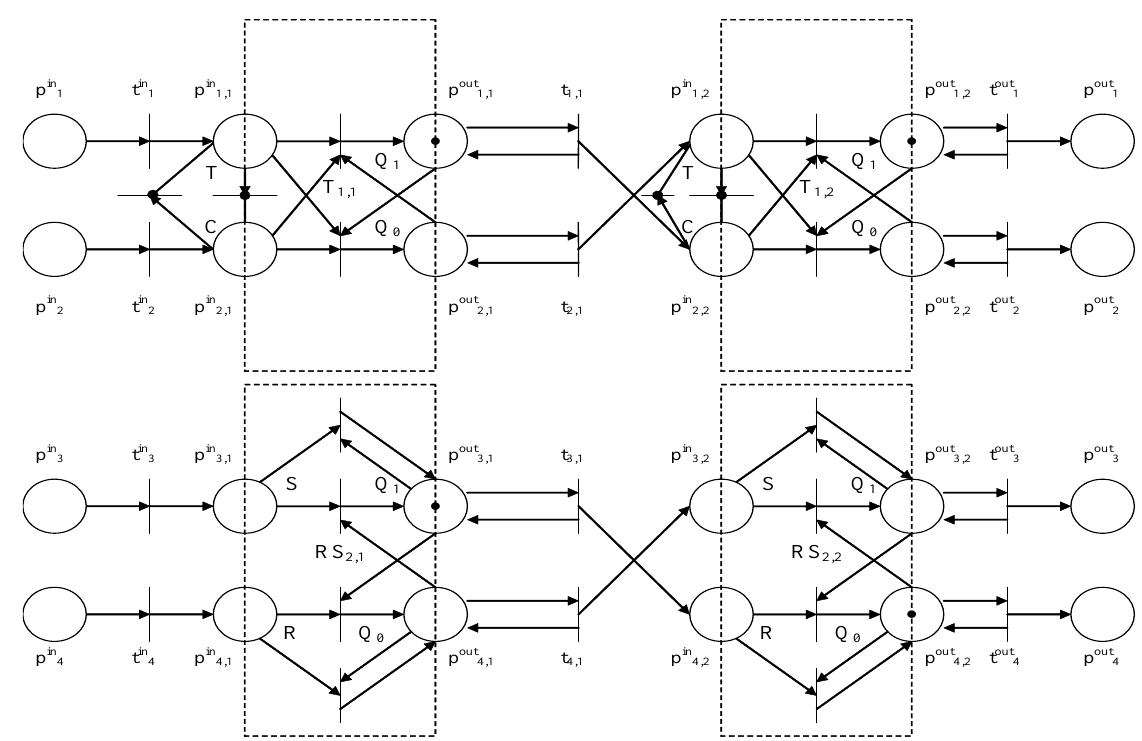
Figure 2. Configuration 1 based on Petri net.